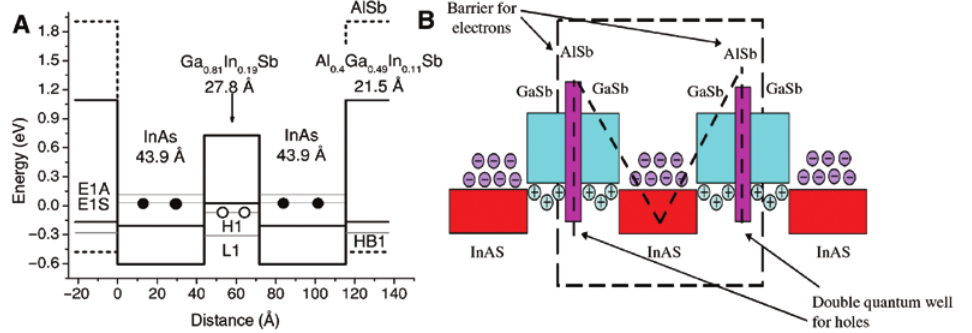
Figure 4: Schematic diagram of W- and M-T2SL LWIR photodiodes. (A) Band profiles of W-T2SL [58] and (B) p-doped M-T2SL structure [59].